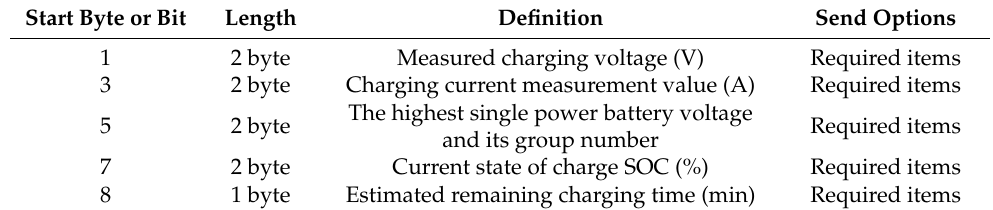
Table 3. Battery charge status message (BCS) information.